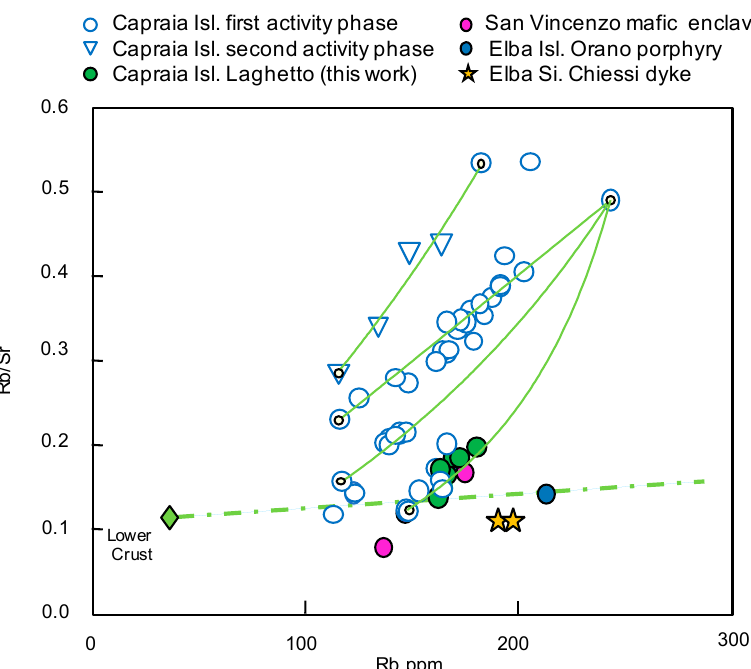
Figure 12. Element vs. element ratio diagrams for the Laghetto and other Capraia rocks. Some Elba dykes [15,35] and mafic enclaves from San Vincenzo [16,34] are also plotted for comparison. The dash-dot line is the melting curve of the lower continental crust. The full lines are possible mixing trends between different end members (circled symbols).